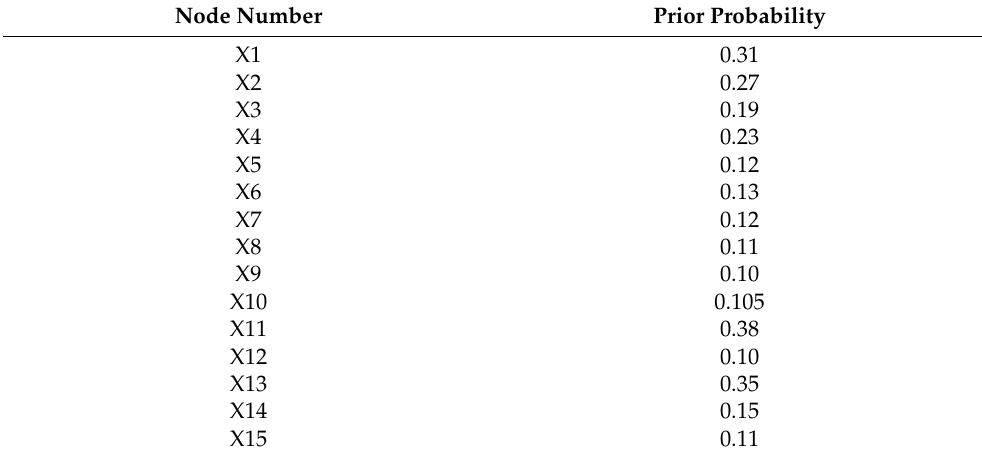
Table A3. Node prior probability.